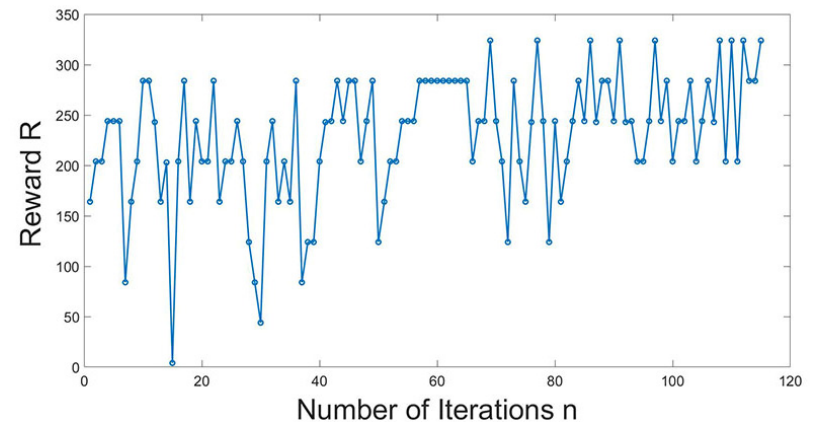
Figure 15. Reward for each episode/iteration.